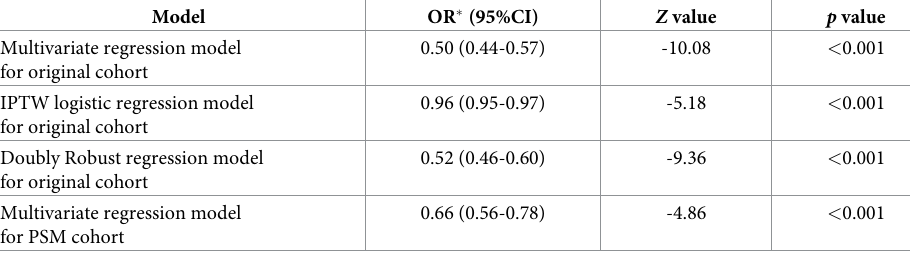
Table 3. Multivariate regression model for hospital